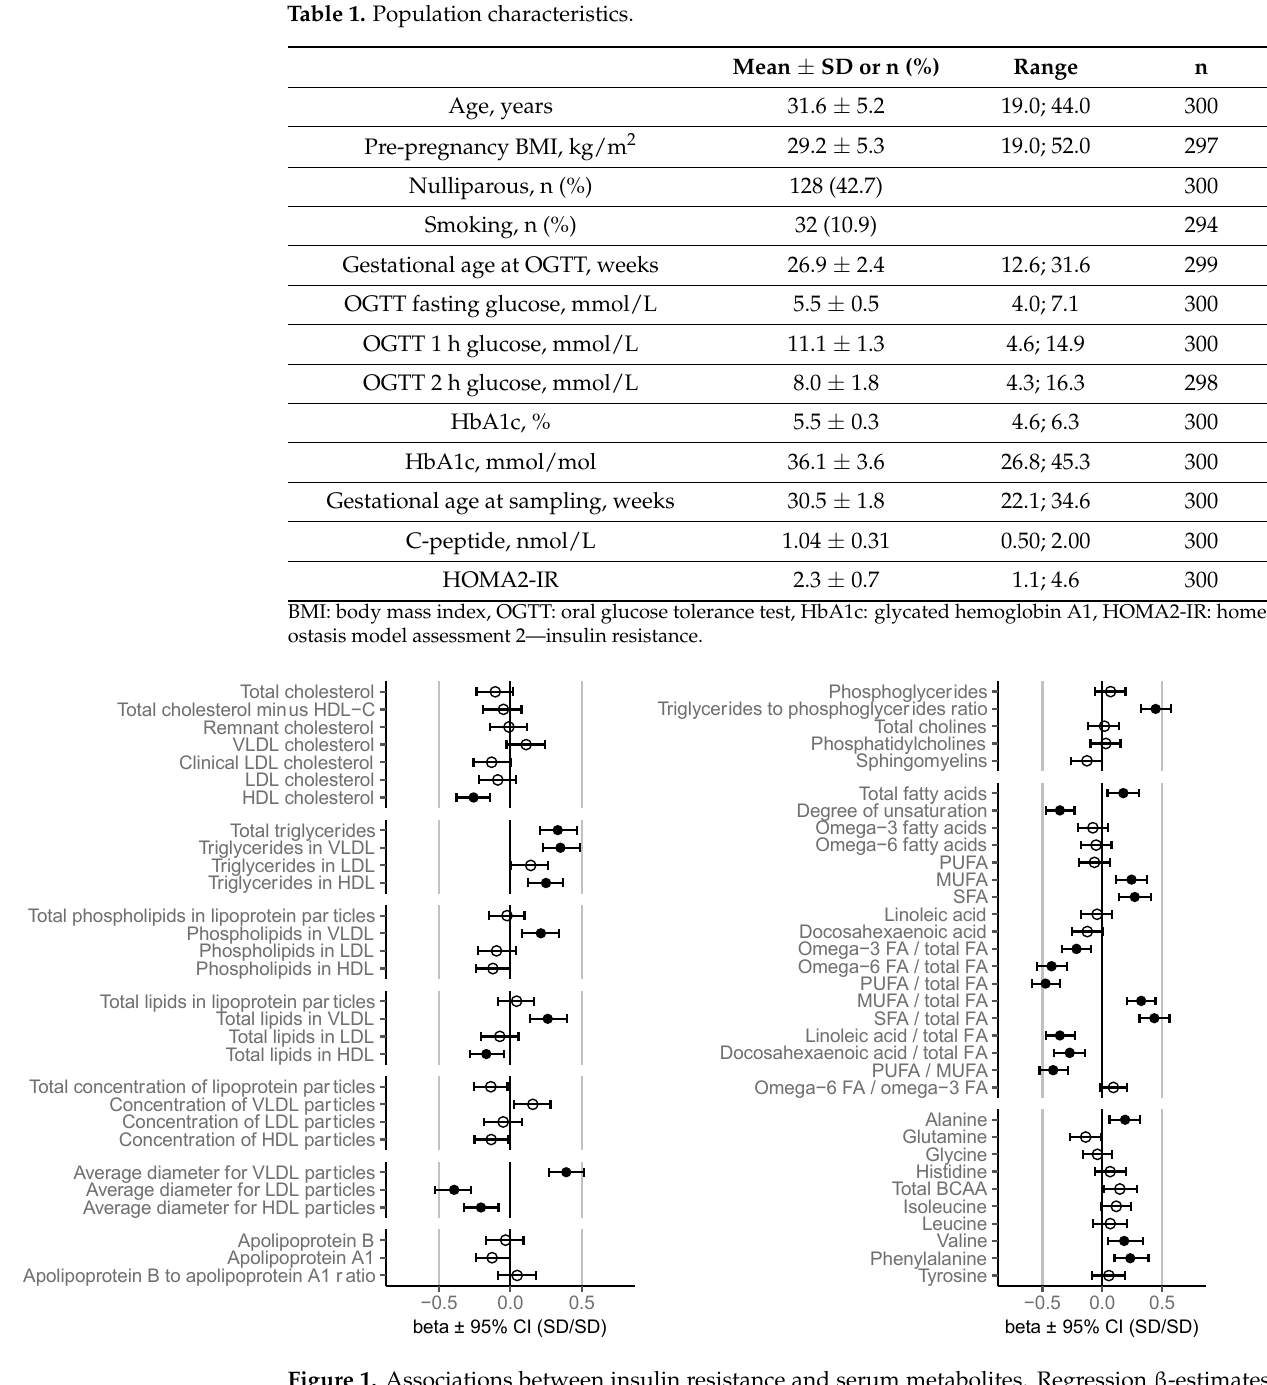
Table 1. Population characteristics.